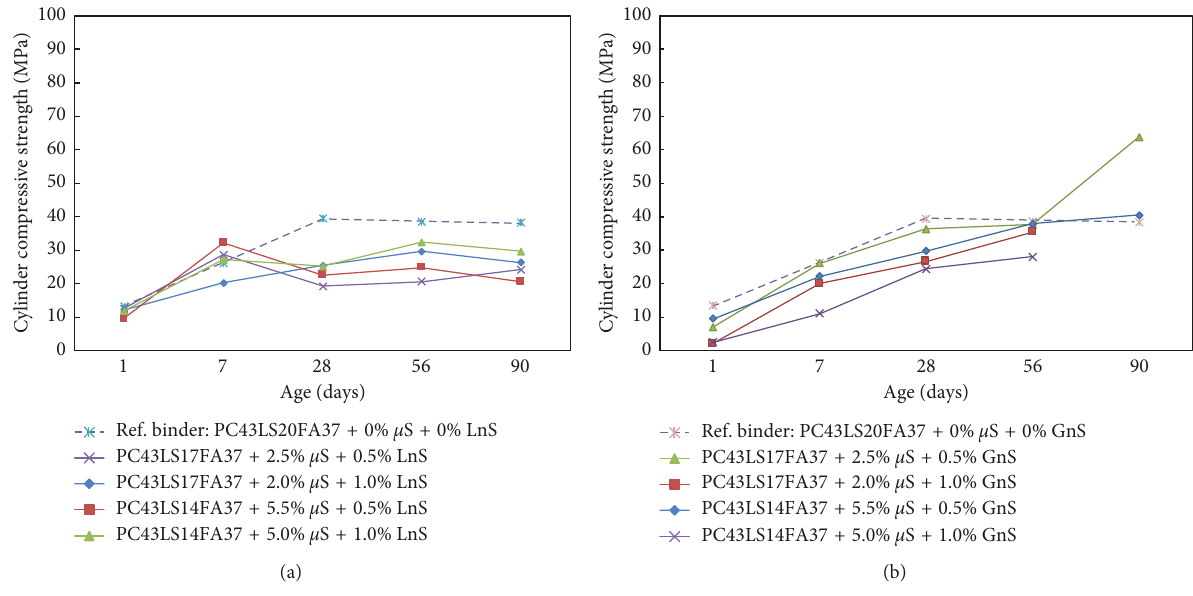
Figure 8: Cylinder compressive strength of μ S and (a) LnS or (b) GnS nanocomposite binders based on